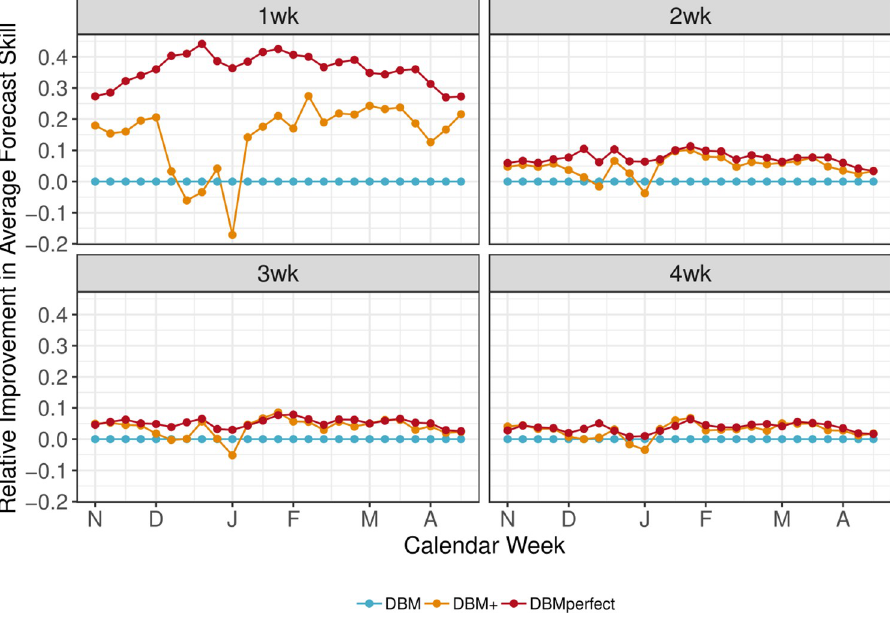
Fig 8. Target and week-specific relative average forecast skill ( s m ,.,., τ , t − s DBM,.,., τ , t ) averaged across all regions and seasons. DBMperfect has better average forecast skill than DBM for all weeks and short-term targets. DBM+ has better average forecast skill than DBM most of the season, but tends to have worse average forecast skill during December and early January—the time of year ILI tends to rapidly increase.